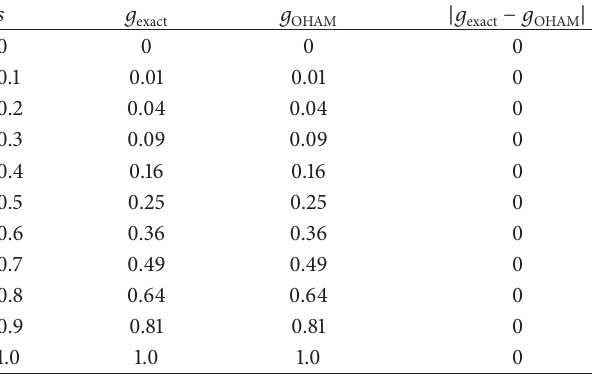
Table 3: Numerical results of Example